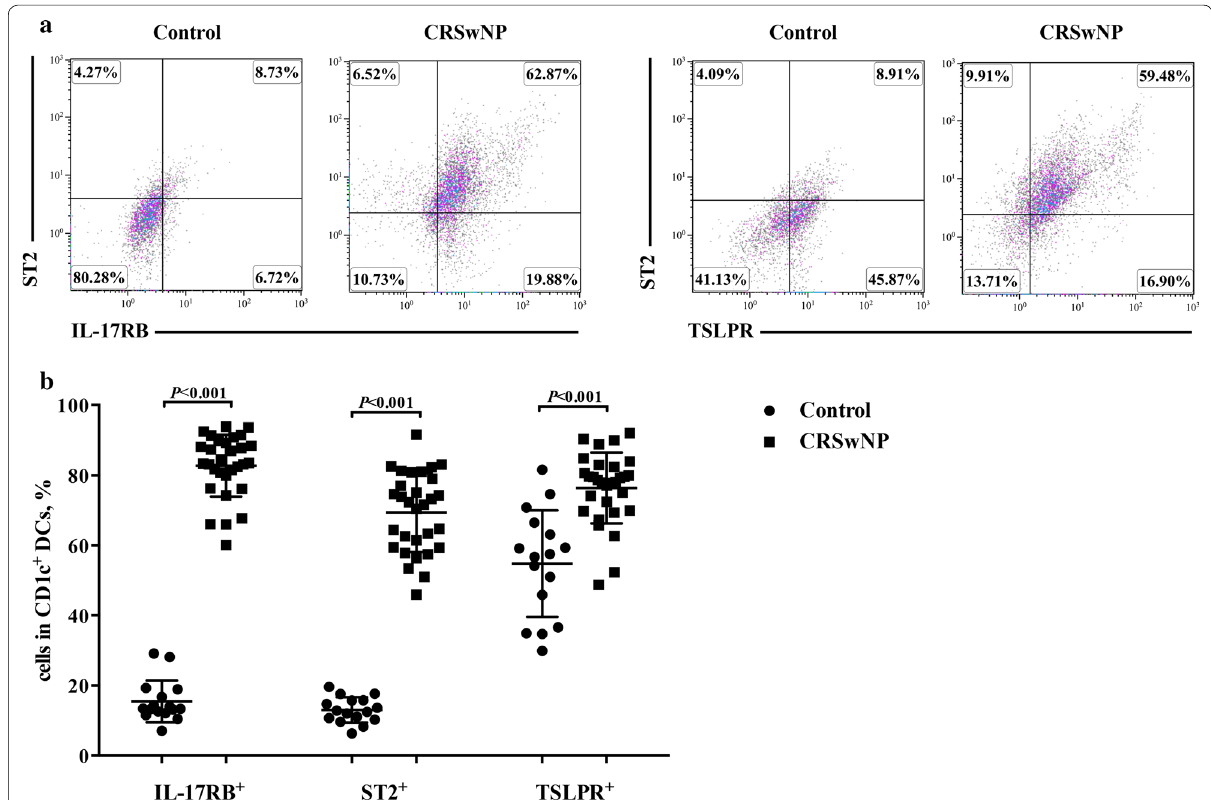
Fig. 3 Expressions of IL‑17RB, ST2 and TSLPR on CD1c + DCs in NP tissues. Representative flow‑cytometry pseudocolor density plots, in which gray‑pink‑blue indicates increasing cell density, showing the IL‑17RB, ST2 and TSLPR expressions by CD1c + DCs in nasal tissues from healthy controls (n 16) and polyp tissues from NP patients (n 30) ( a ). Quantification of IL‑17RB, ST2 and TSLPR expressions by CD1c + DCs ( b ). Data are presented = = as a percentage of the positive cells in CD1c + DCs and mean with SD or median with